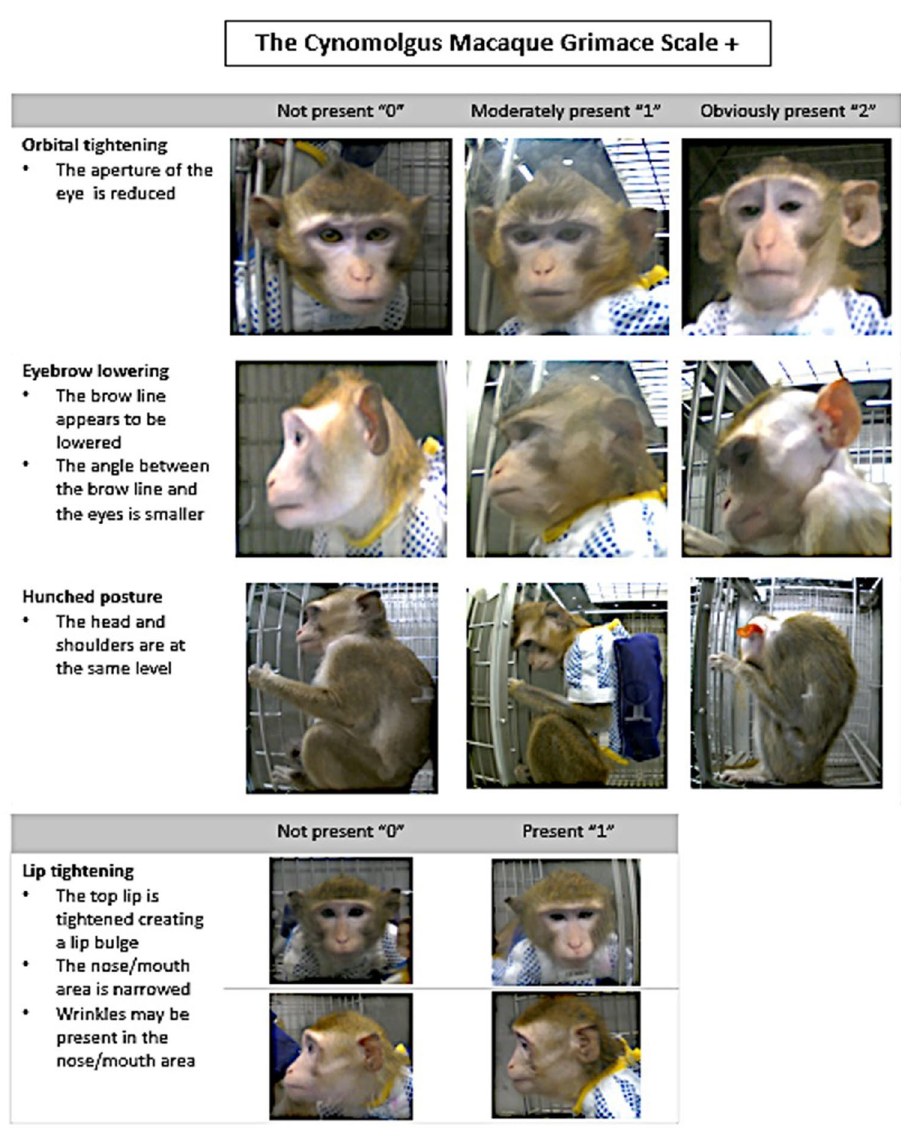
Figure 2. Cynomolgus Macaque Grimace Scores are significantly increased from baseline after surgery. Boxplot demonstrating median (solid line) and the interquartile range of the CMGS scores across timepoints pre- and post-surgery. The whiskers indicate the range and circles the extreme values. The lines in the x axis indicate that timepoints are not linear. The CMGS scores increased during the first four timepoints following surgery (pairwise comparison with Tukey’s adjustment, p < 0.0001). Timepoints start from up to 168 h before surgery (1B: 06:30–7:30 (cohort 1) or 07:00–08:00 (cohort 2), 2B:16:00–17:00, 3B:17:00–18:00, 4B:18:00–19:00)